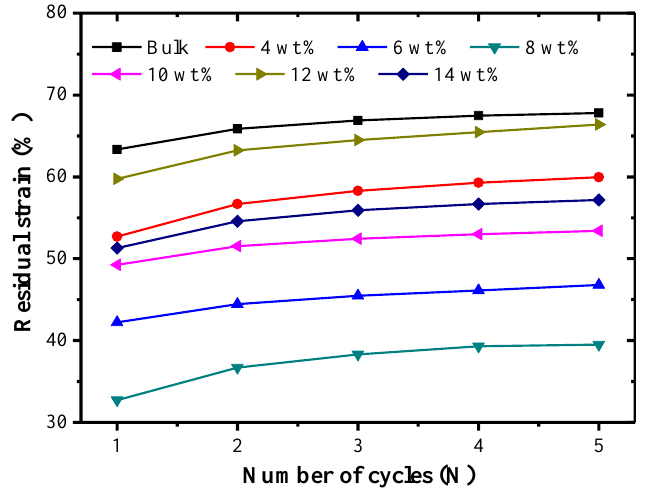
Figure 13. The effect of the number of cycles on the residual strain of SMP composites with different chopped carbon fiber contents.